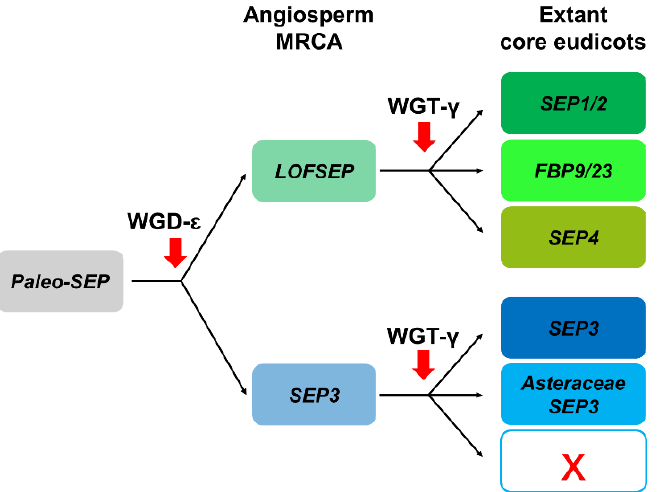
Figure 6. Representation of the most likely pattern that drove the evolution of the SEPALLATA ( SEP ) subfamily in extant core eudicots, based on our analysis and previous works.